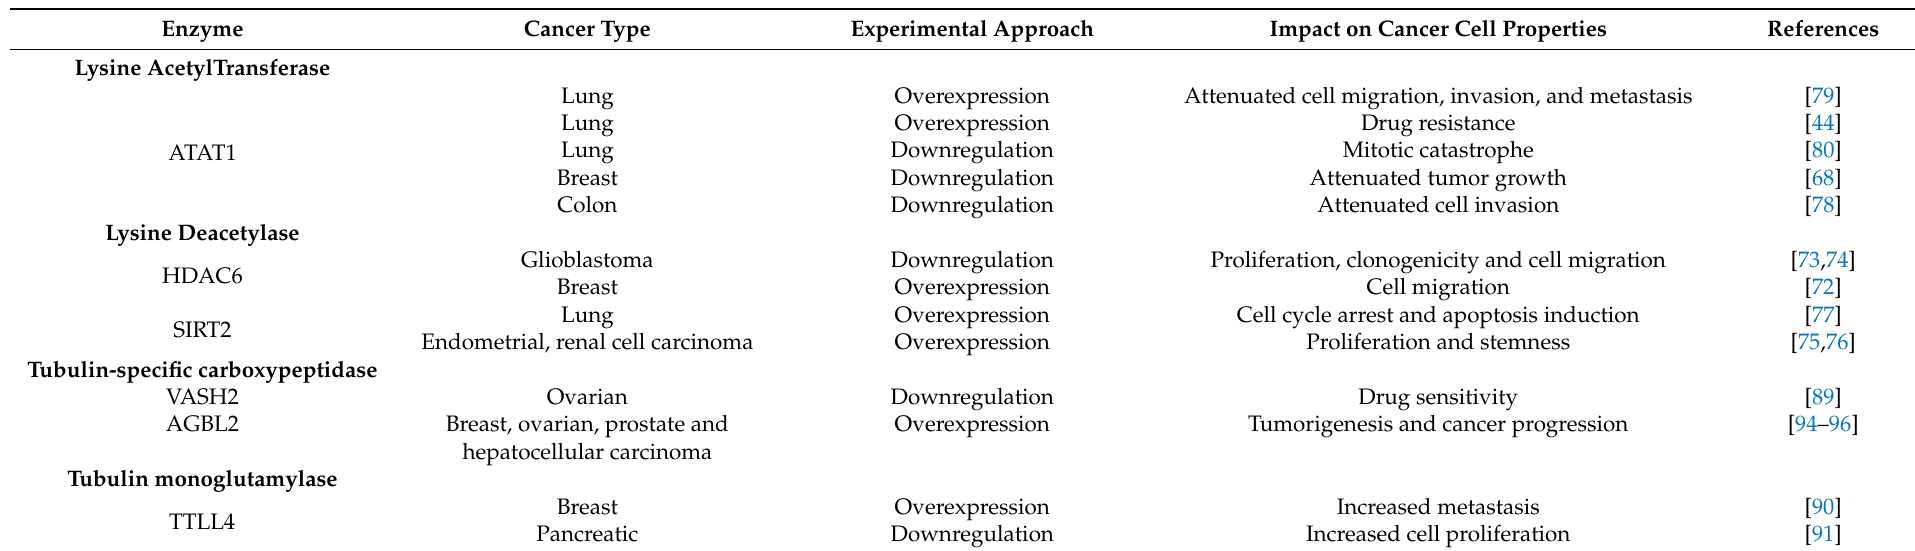
Table 3. Impact of tubulin-modifying enzymes on different cancer